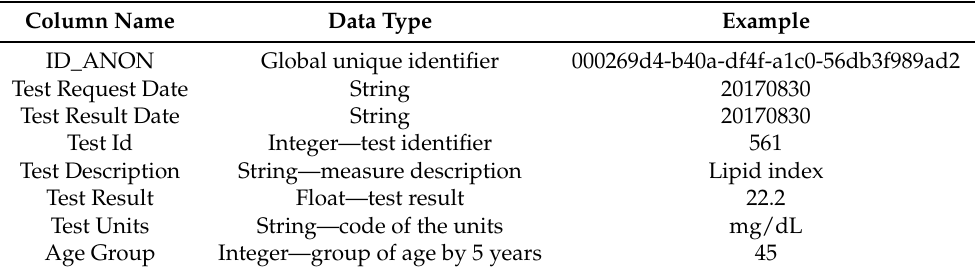
Table 5. Laboratory table